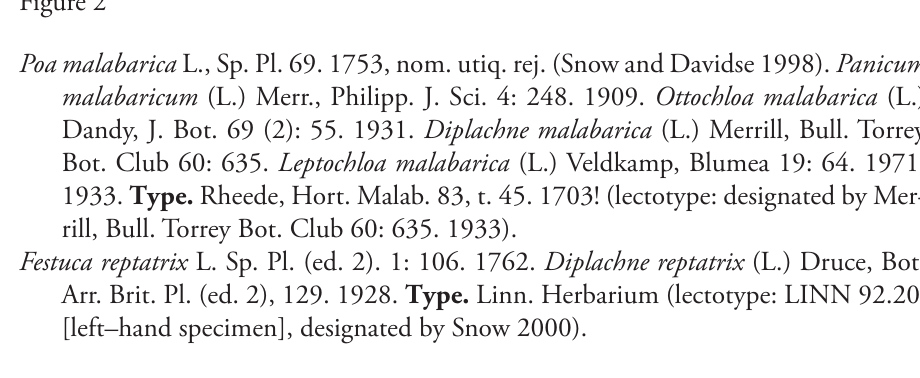
Diplachne fusca (L.) P. Beauv. ex Roem. & Schult. subsp . fusca